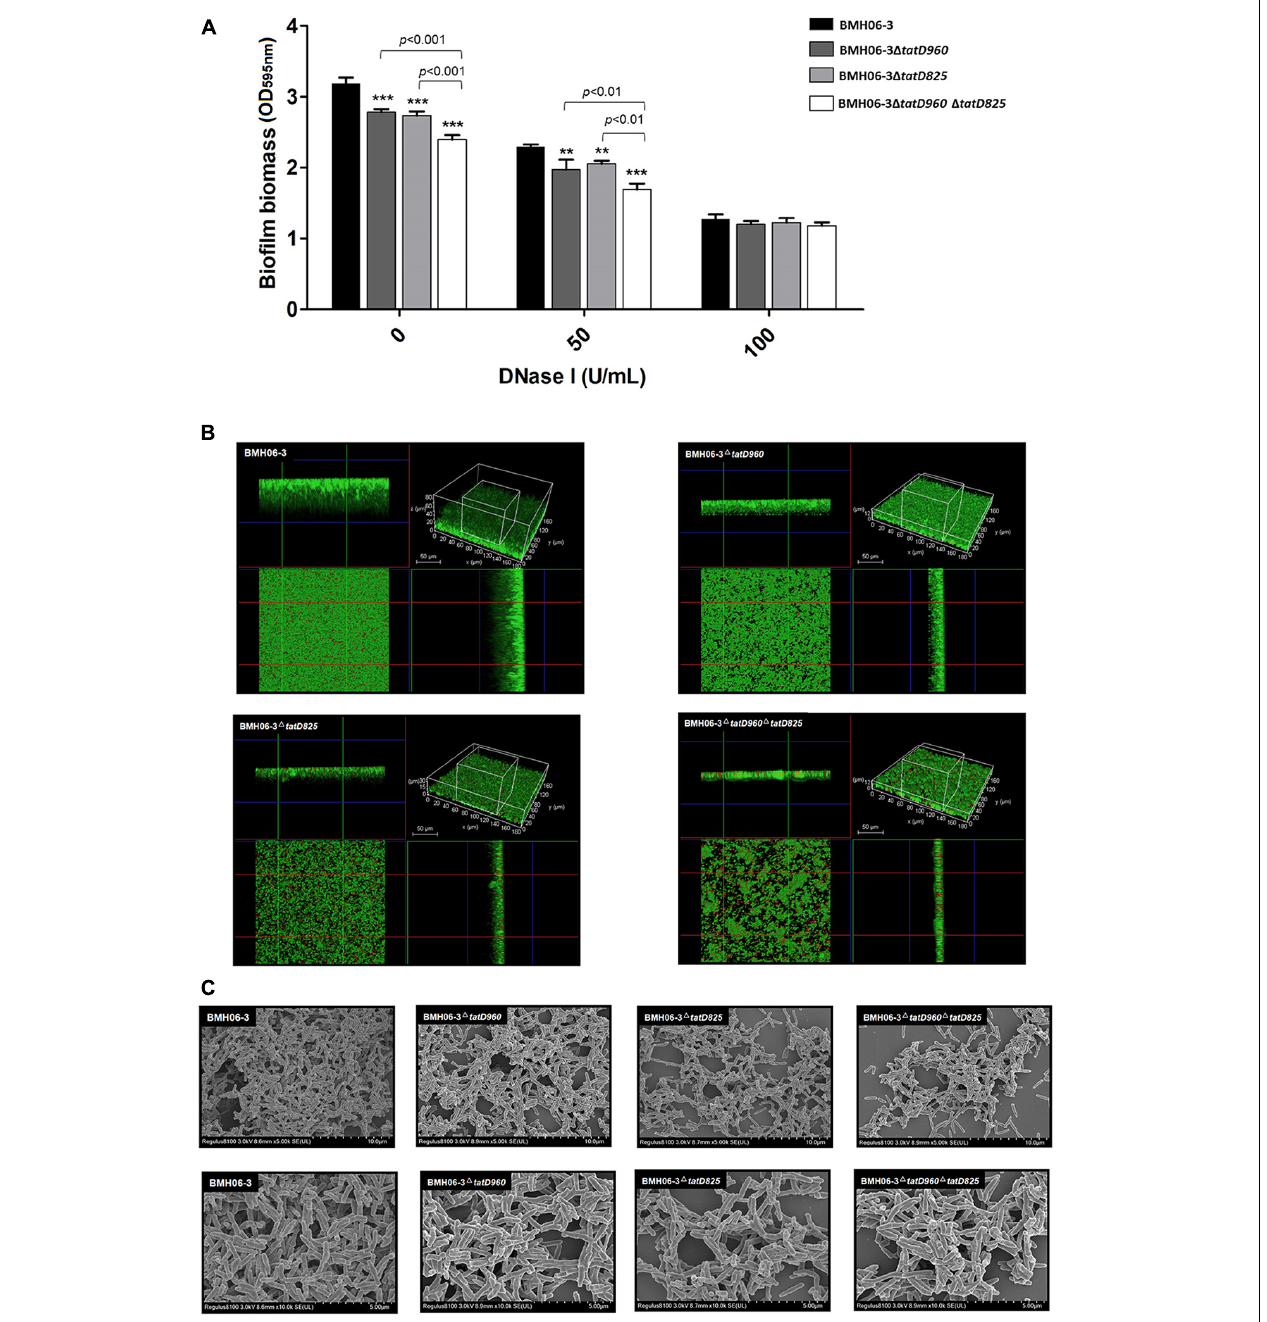
FIGURE 5 | Biofilm biomass assay and morphology with the wild-type strain and tatD -deficient mutants. (A) eDNA is important for T. pyogenes BMH06-3 biofilm formation. The addition of DNase I (100 U/mL) at the time of inoculation eliminated the biofilm biomass difference among the wild-type strain and tatD -deficient mutants. Statistical analysis was carried out using one-way of variance (ANOVA) on SPSS Statistics V17.0. Statistical significance compared with the control group (BMH06-3) was defined as ** p < 0.01 and *** p < 0.001. (B) CLSM analysis of biofilm thickness and denseness after 48 h of incubation in the static state. (C) SEM images of T. pyogenes biofilms after incubation for 48 h. Biofilms were imaged at × 5,000 (top) and × 10,000 (bottom)